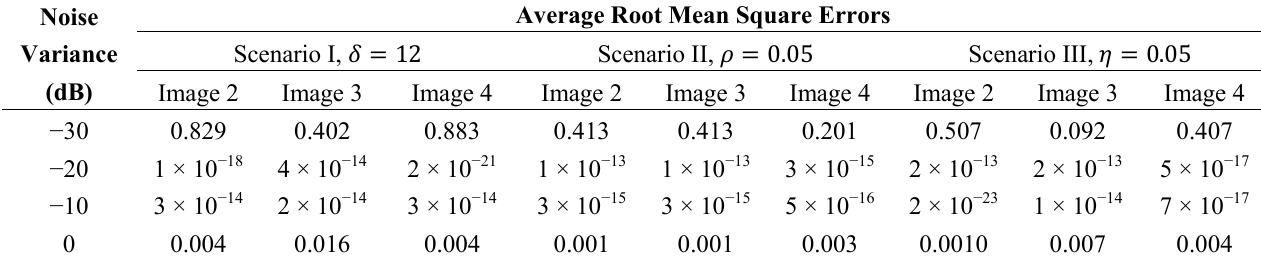
Table 9. The p -value from the pairwise t -test between the traditional registration method and our proposed algorithm for various scenarios at β (cid:3404) 0.75.